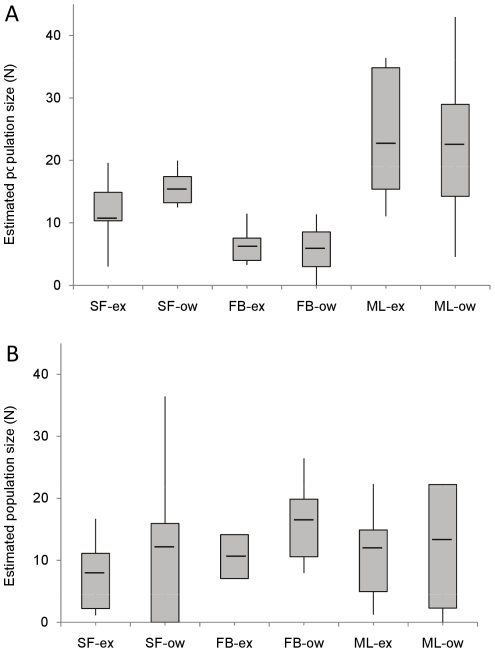
Summary plots of model averaged population size estimates.A. Bank Voles. B. Wood Mice. Sites: Swinford (SF), Firebreak (FB) and Marley (ML), exclosure (-ex), open woodland (-ow). Summary plots showing maximum, upper quartile, mean, lower quartile and minimum values for population size across the trapping season (June–November). The model averaged estimates for population size (N) from the multi-state Robust Design method gave equivalent estimates for deer-free exclosures and open woodland transects at each site. Bank vole numbers varied significantly by site (χ2
2 = 53.73, p<0.001), but wood mice did not (χ2
2 = 3.2, p>0.1).